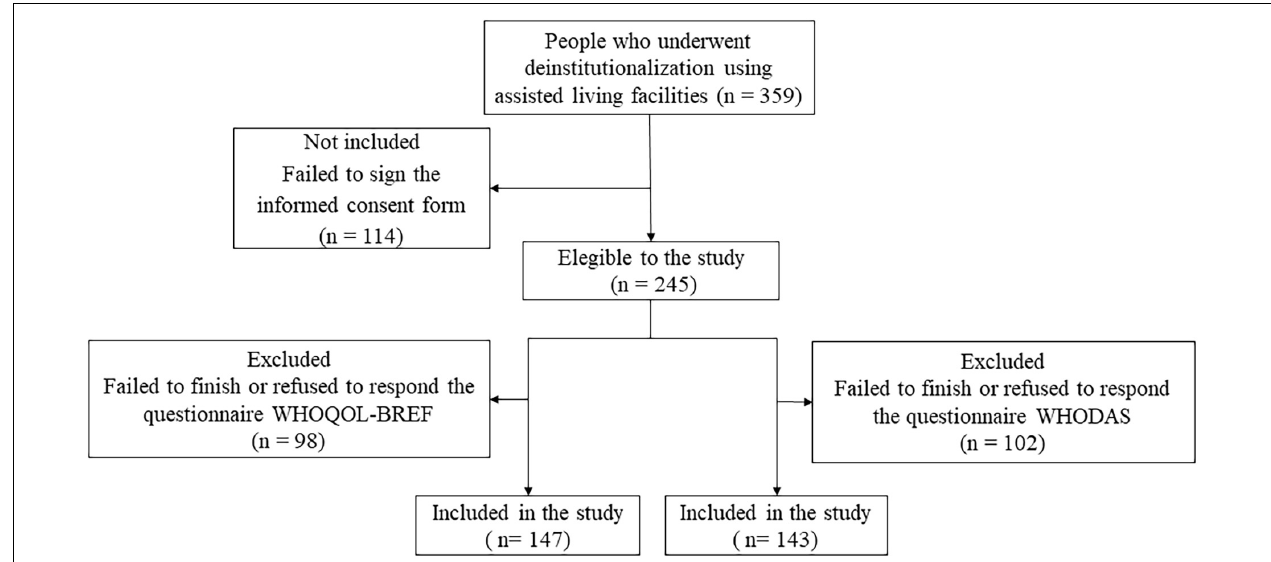
FIGURE 1 | Flowchart of Sample Composition. WHOQOL-BREF, World Health Organization Quality of Life. WHODAS 2.0, World Health Organization Disability Assessment Schedule.